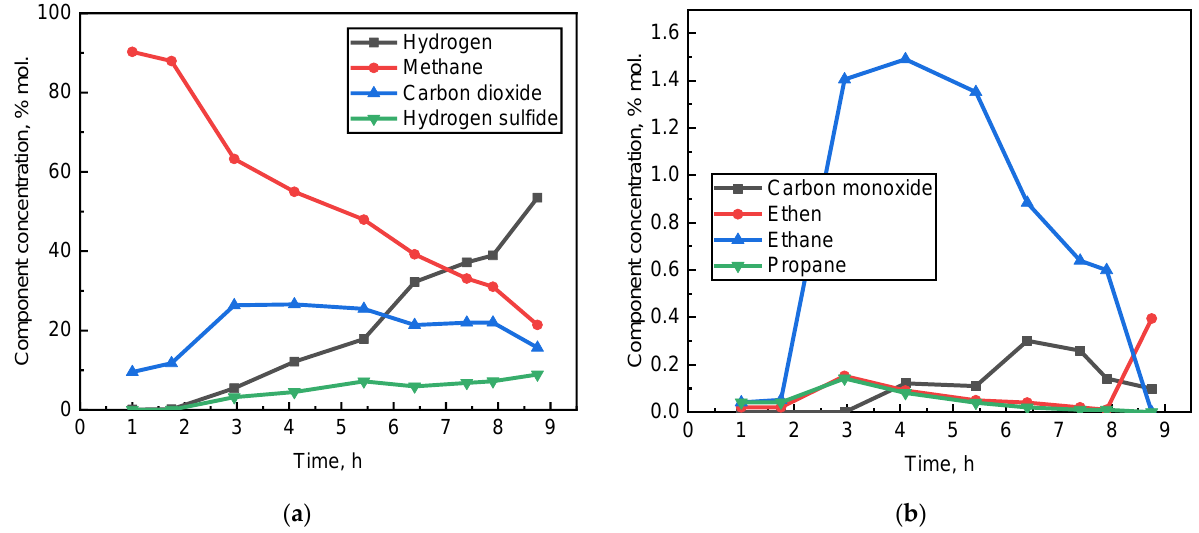
Figure 6. ( a ) The dependencies of major gas component concentrations and ( b ) minor gas component concentrations in product gas mixture in experiment No. 6 on time.